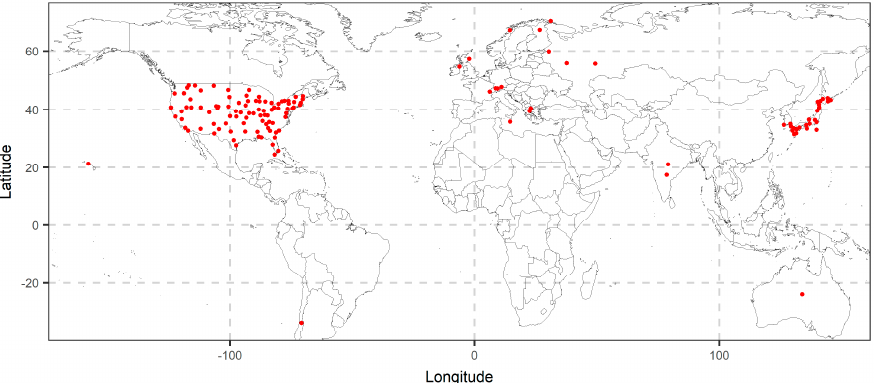
Figure 2. Map of locations for the 135 stations used in the analysis.